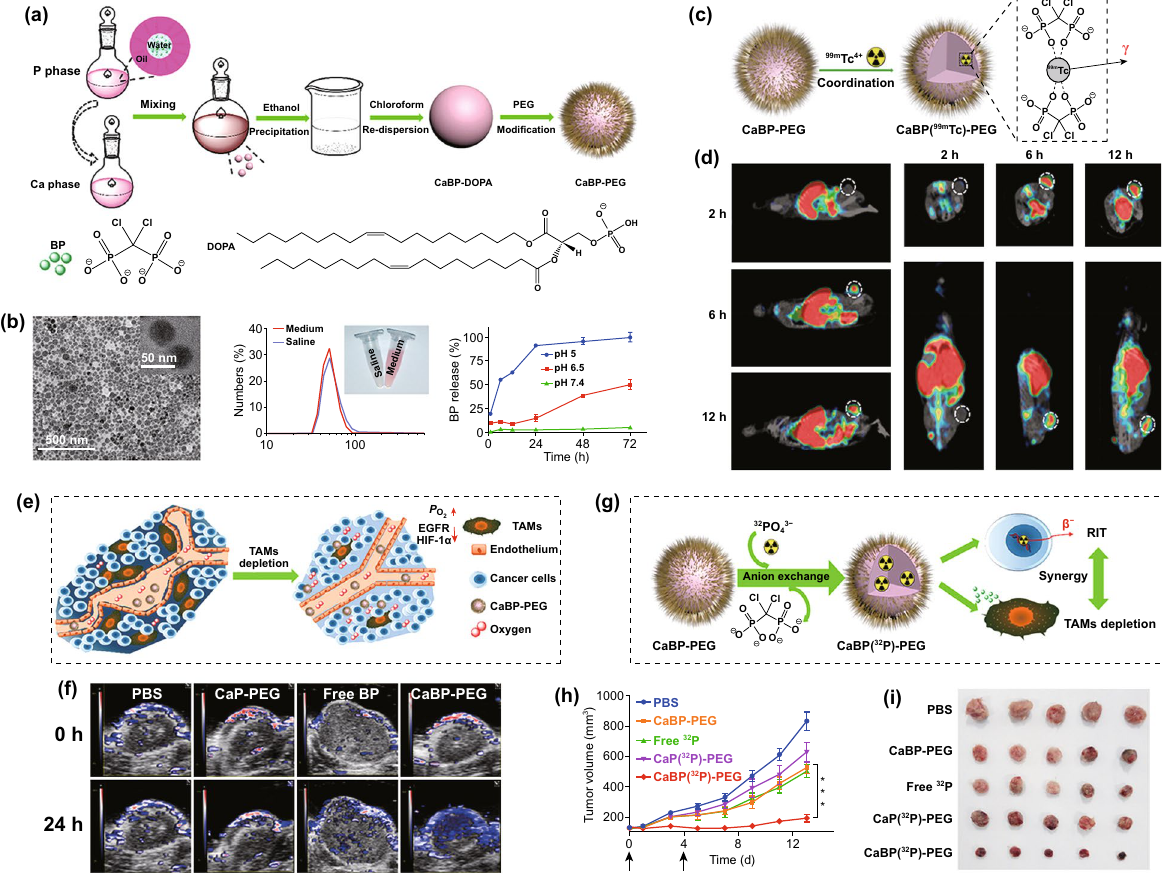
Fig. 12 a Schematic illustration to show the preparation of CaBP nanoparticles. b TEM image and dynamic light scattering data and photo of CaBP-PEG nanoparticles in PBS and cell culture medium buffer, as well as release of BP from CaBP-PEG nanoparticles under different pH values. c Scheme illustrating the 99 mTc radiolabeling of CaBP-PEG nanoparticles for tracing the in vivo fate of nanoparticles. d SPECT images of mice at 2, 6, and 12 h after intravenous injection of CaBP( 99 mTc)-PEG nanoparticles. Tumors of mice are highlighted by the dotted circles. e Scheme showing the normalized tumor vasculature, enhanced perfusion, and relieved tumor hypoxia after TAM depletion. f Scheme illustrating CaBP(32P)-PEG nanoparticles for synergistic combination RIT with TAM depletion. g Photoacoustic imaging showing tumor saturated O 2 lev- els of mice after i.v. injection of PBS, CaP-PEG, free BP, or CaBP-PEG nanoparticles. h Tumor volume curves of mice with various treatments. Doses for each injection: 100 μCi of 32P, 200 μg of BP. The mice were treated twice at day 0 and 4 (black arrows). i Photographs of tumors col- lected on the 14th day after the first treatment. Reproduced with permission from Ref.